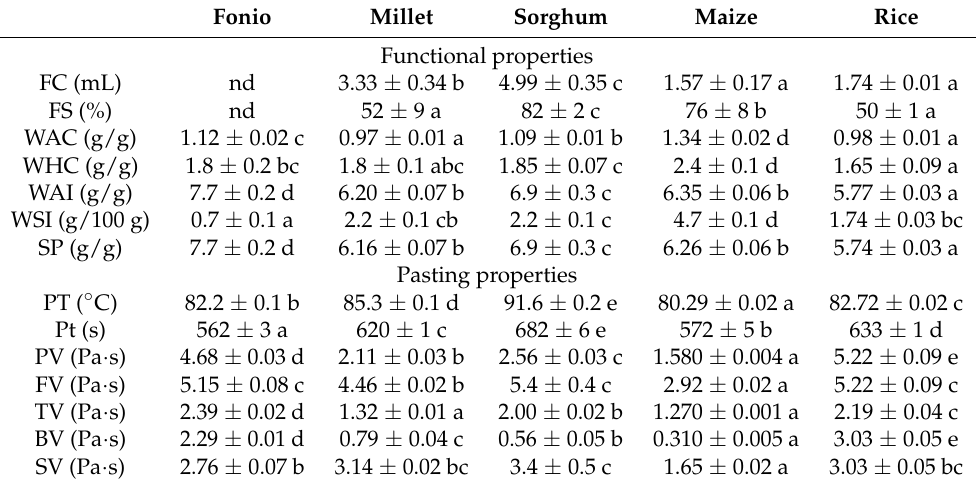
Table 2. Functional characteristics and pasting properties of fonio flour compared to other gluten- free flours. Fonio Millet Sorghum Maize Rice Functional